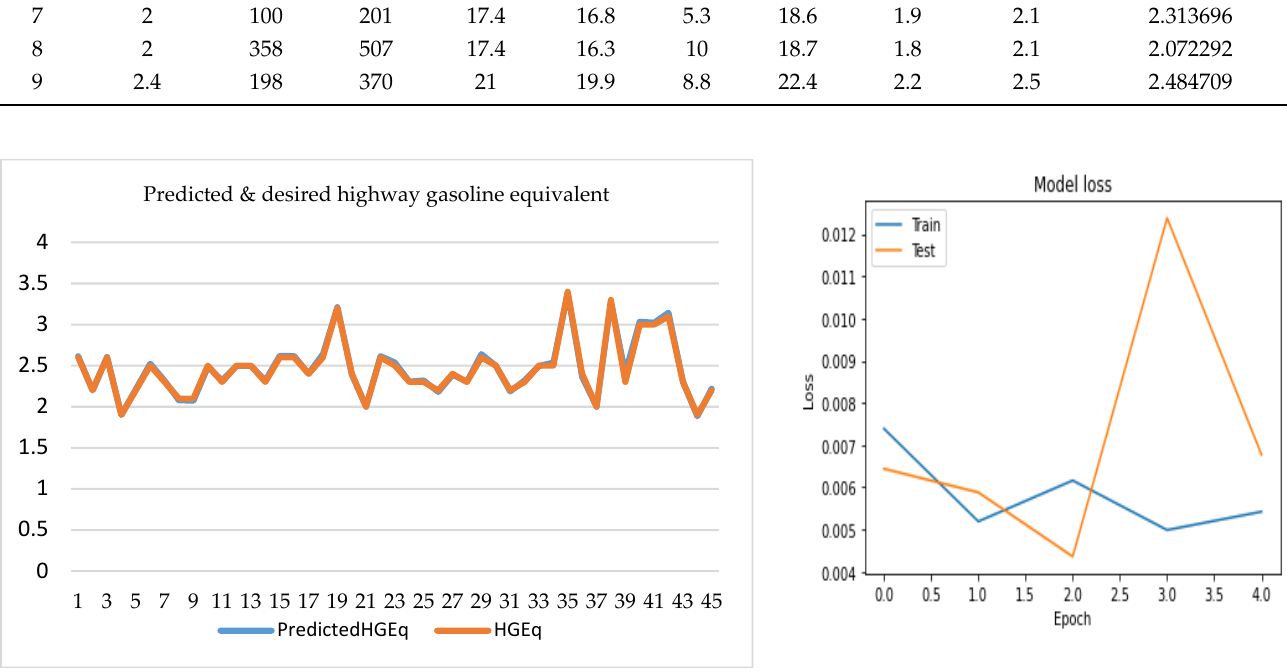
Figure 11. Highway gasoline litre consumption equivalent analysis. ( a ) Behaviour of the highway litre consumption equivalent; ( b ) Model loss with increase in epoch. Table 7. Predicted and desired highway gasoline litre consumption equivalent.